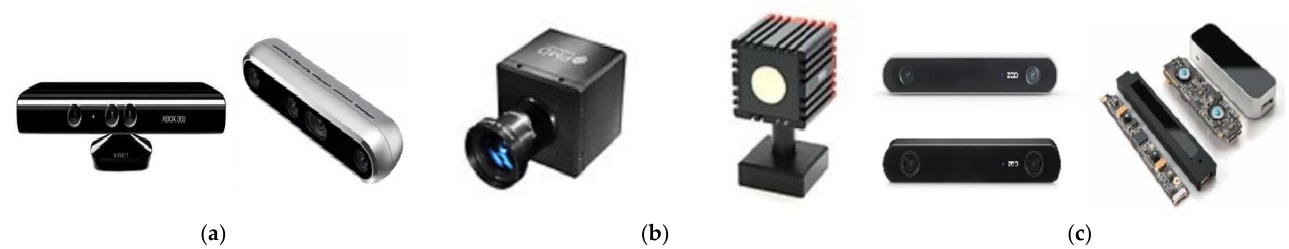
Figure 1. Depth cameras with different imaging principles. ( a ) Structured light camera; ( b ) Time of Flight camera; ( c ) Binocular vision camera.